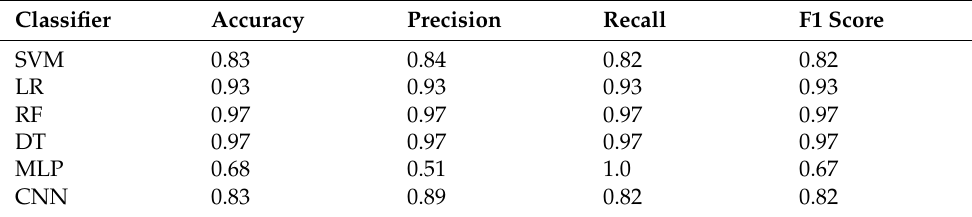
Table 3. Results of machine learning and deep learning classifiers for 60–40